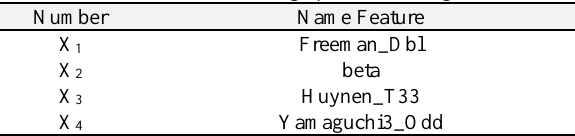
Table 4. Selected features using optimization algorithms SFS